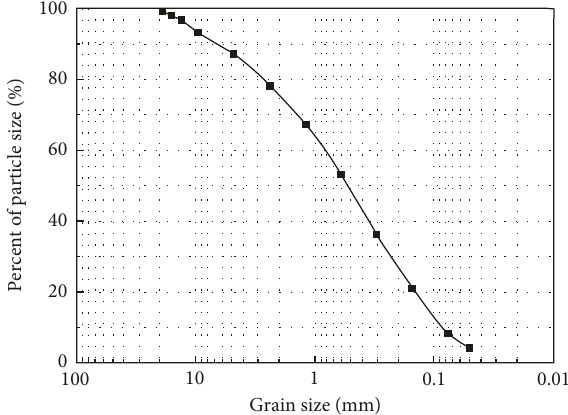
Figure 4: Particle size distribution of soil sample.